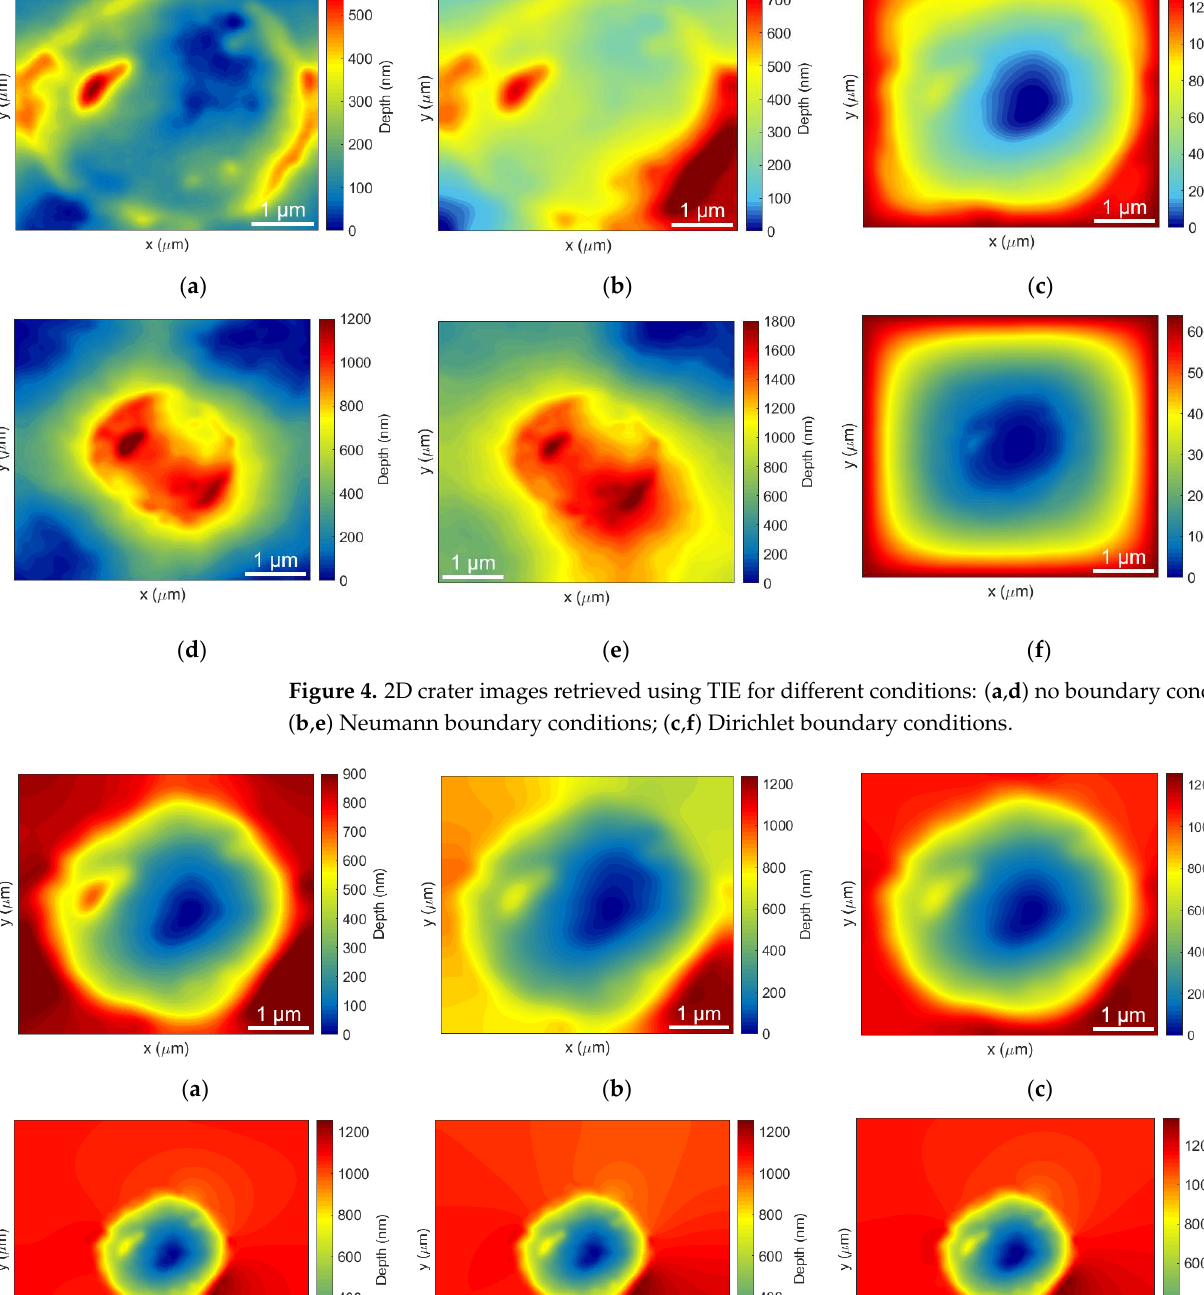
Figure 4. 2D crater images retrieved using TIE for different conditions: ( a , d ) no boundary condi- tions; ( b , e ) Neumann boundary conditions; ( c , f ) Dirichlet boundary conditions.